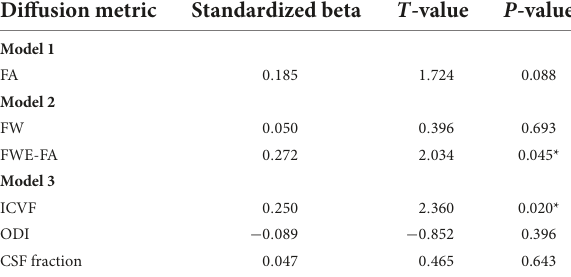
TABLE 4 Summary of linear regression models with diffusion metrics extracted from the WMN-WM mask predicting working memory